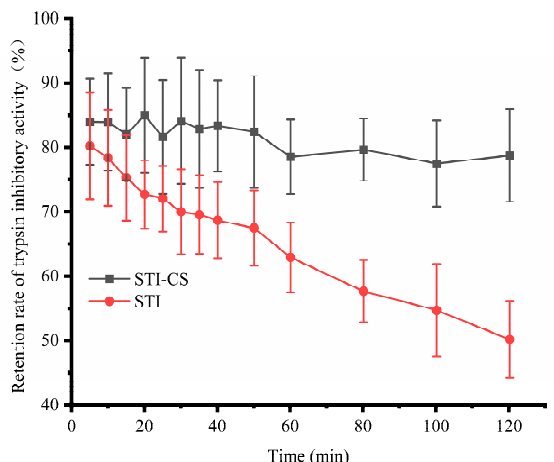
Figure (cid:561) 8. (cid:561) The (cid:561) e (cid:283) ect (cid:561) of (cid:561) CS (cid:561) complex (cid:561) coacervates (cid:561) on (cid:561) STI (cid:561) stability. (cid:561) Figure 8. The effect of CS complex coacervates on STI